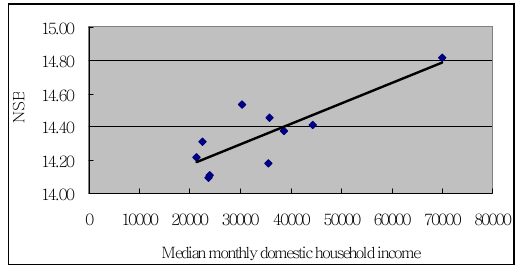
Figure 9. Relationship between NSB and household income in district scale (R 2 = 0.68)